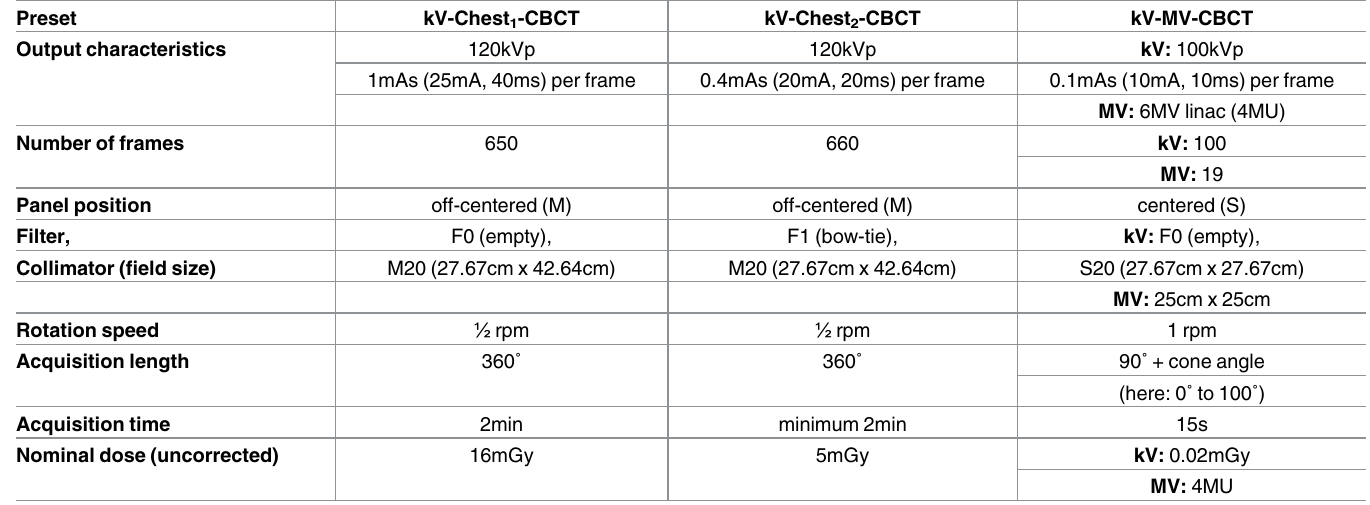
Table 1. Technical setup of applied imaging